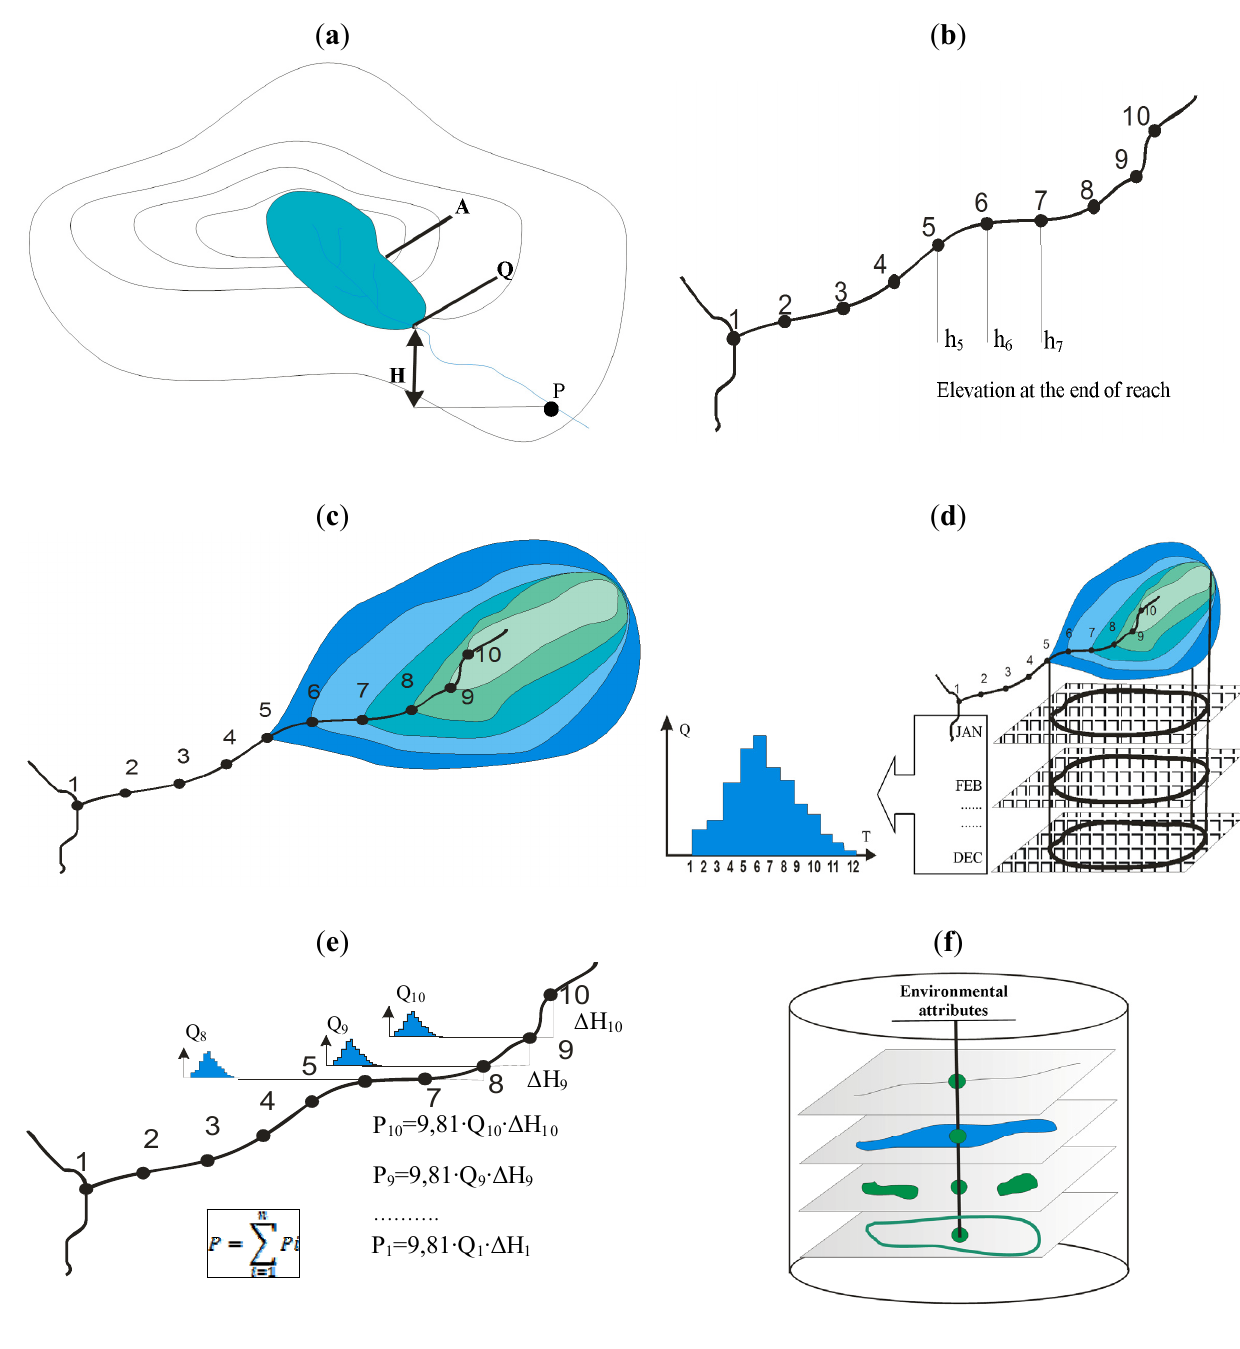
Figure 3. Detailed scheme of GIS application for hydropower estimation in the river basin: ( a ) The river basin foreseen for hydropower development. A-catchment area, H-elevation drop, Q- stream flow, P-stream power; ( b ) The river split into equal reaches (h , h , h -elevation of water level at the end of river reach). The input data: hydrographic 5 6 7 network and DEM of river basin; ( c ) Estimation of stream segment catchment area. The input data: hydrographic network and river catchment area with DEM; ( d ) Calculation of monthly river flow for every segment to obtain the input data from GIS layers; ( e ) Calculation of hydropower potential; ( f ) Evaluation of limiting factors for every reach (such as protected areas, agriculture, and